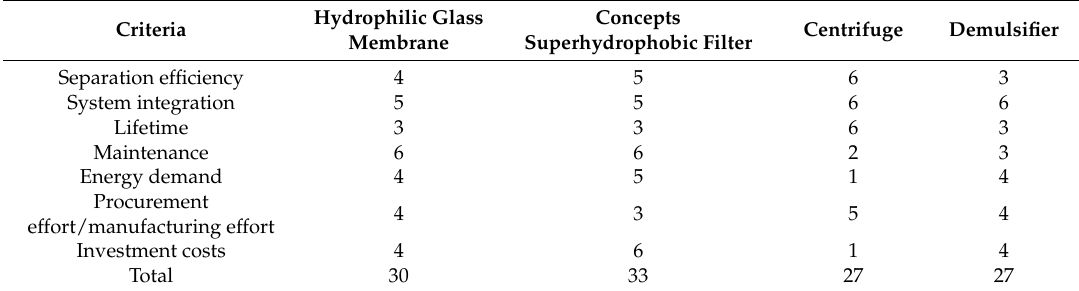
Table 1. Evaluation of the four different concepts. The concepts are rated on a scale from one to six in seven different categories. The highest value being six, and the lowest 1. A maximal total of 42 can be reached for each separation technique. As it can be observed, thanks to low energy demand, low costs of maintenance and investment, superhydrophobic filters score the highest grade in the table, therefore being the most suitable technique for this research